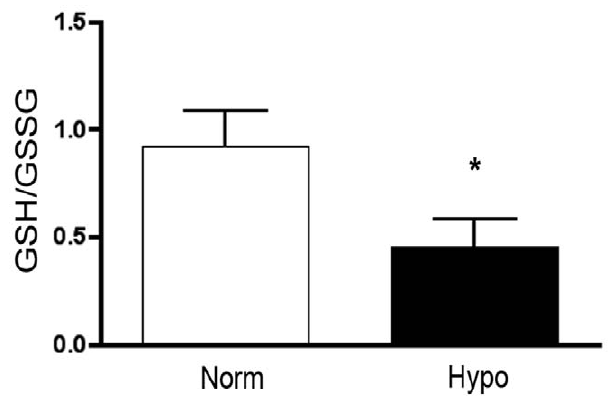
Figure 2. The GSH/GSSG ratio is decreased in the pulmonary artery of the chronic hypoxic calf (Hypo) compared to the normoxic control calf (Norm). A. GSH and total glutathione levels were measured and data expressed as the ratio of GSH to GSSG. Data expressed as mean 6 SEM. *p , 0.05 vs. Norm; n=4.